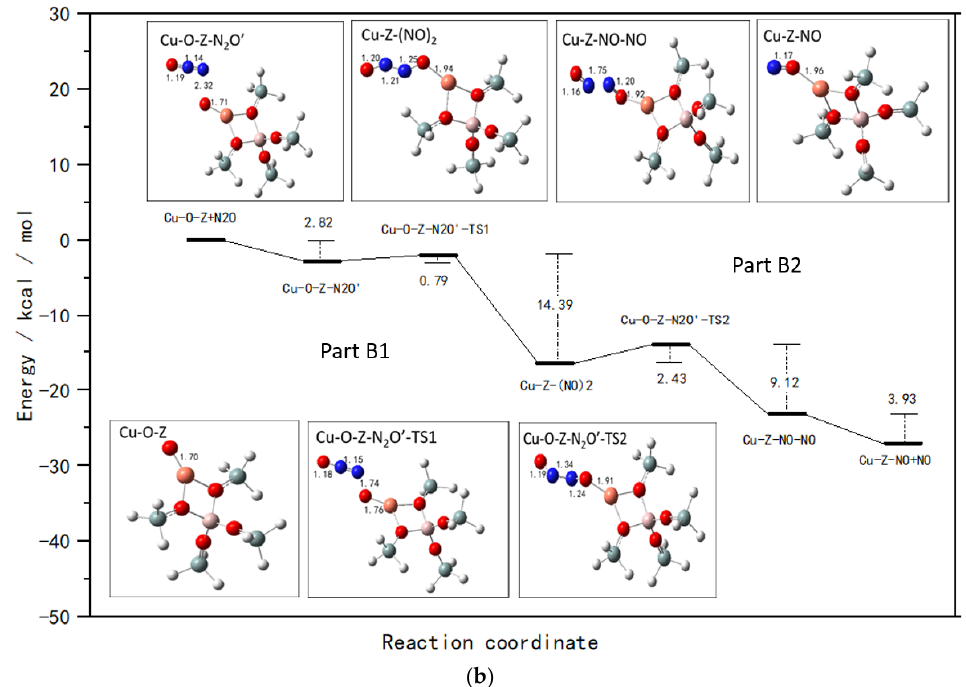
Figure 2. Energy profile for O 2 formation mechanism ( a ); Energy profile for NO formation mechanism ( b ).